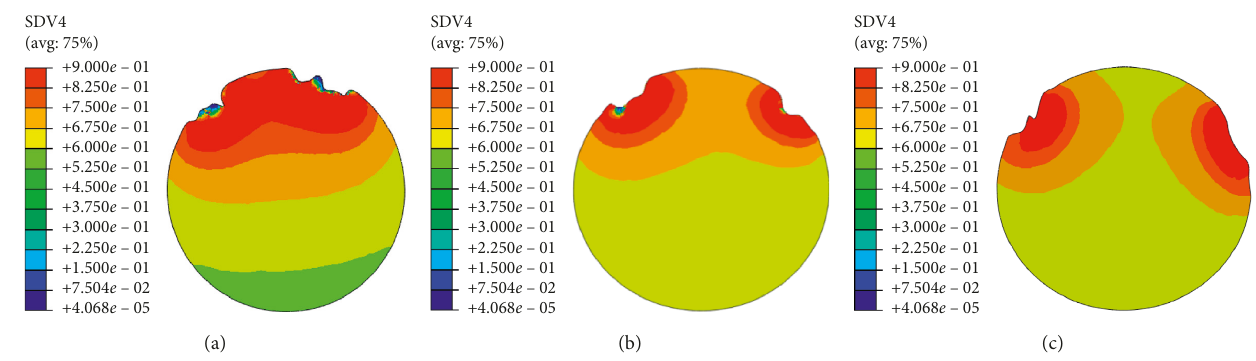
Figure 23: Damage cloud map of steel wires corresponding to the points in Figure 22.